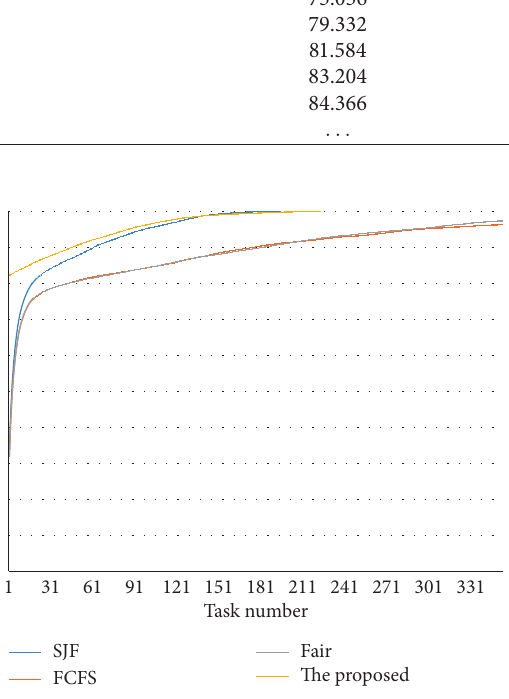
Figure 7: Task congestion degree